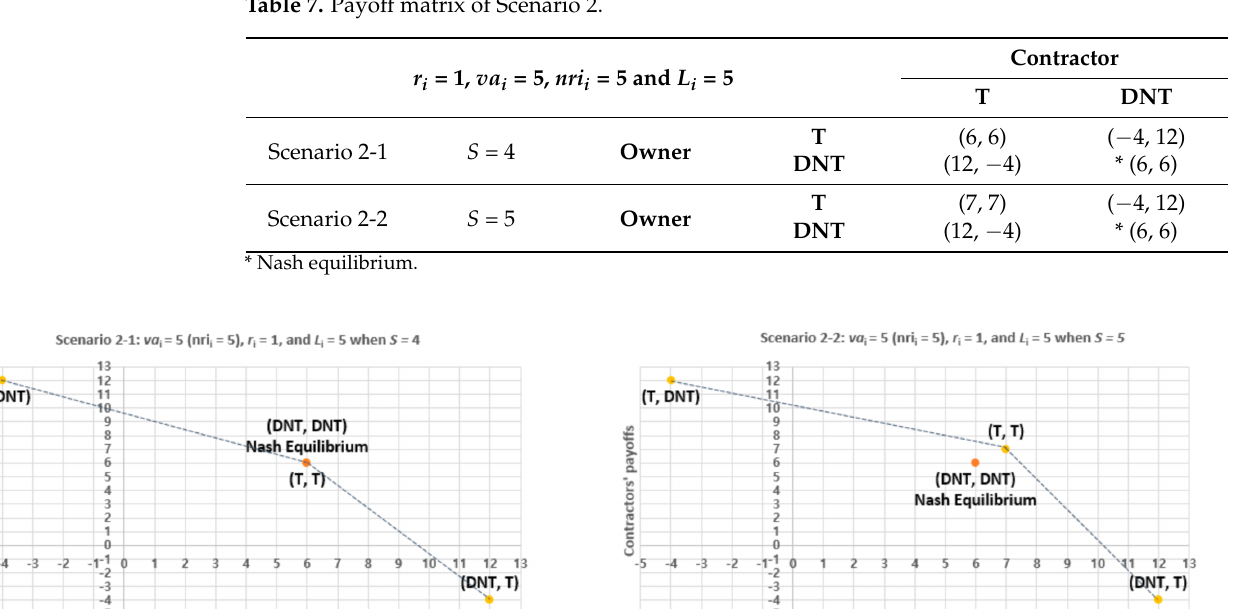
Table 7. Payoff matrix of Scenario 2.